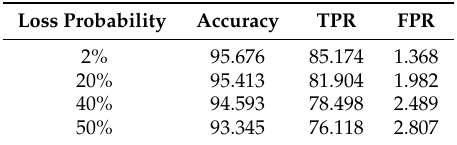
Table 7. Cluster-based detection against packet loss.